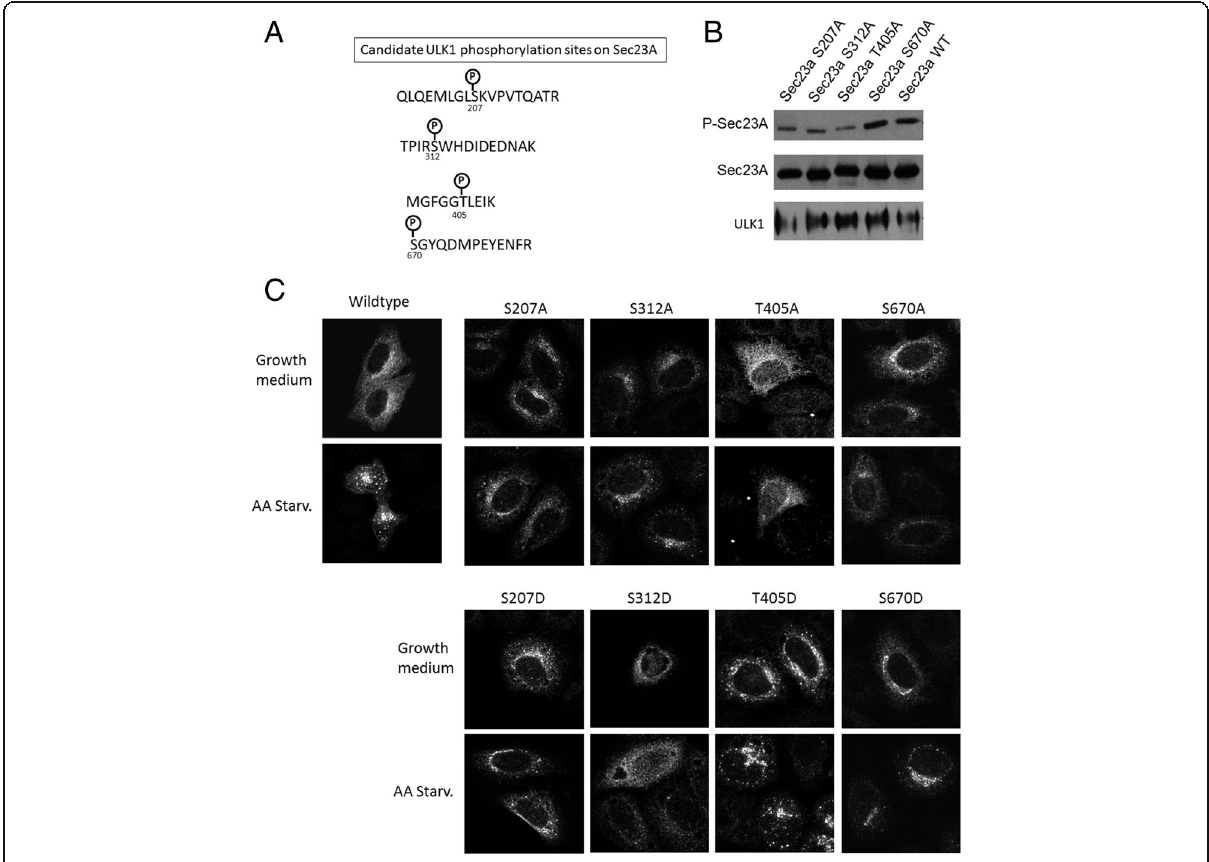
Fig. 5 Identification of ULK1 phosphorylation sites on Sec23A. a Candidate ULK1 phosphorylation sites on Sec23A. b Various phospho-deficient mutants were tested for ULK1 phosphorylation. This experiment was similar to that in Fig. 3b with ULK1 activated, but in addition to wild type Sec23A, four alanine mutants of Sec23A were also used. c Phospho-deficient and phospho-mimicking mutants of Sec23A were analyzed for their morphology. Hela cells were transfected with wild type or indicated mutants of Myc-Sec23A and the Myc-Sec23A mutants were stained with anti-c-Myc antibody.Amino acid starvation was induced to cell for 2 h before fixation and staining ( lower rows ). Cell in the non-starved condition was cultured in complete growth medium before fixation ( upper rows